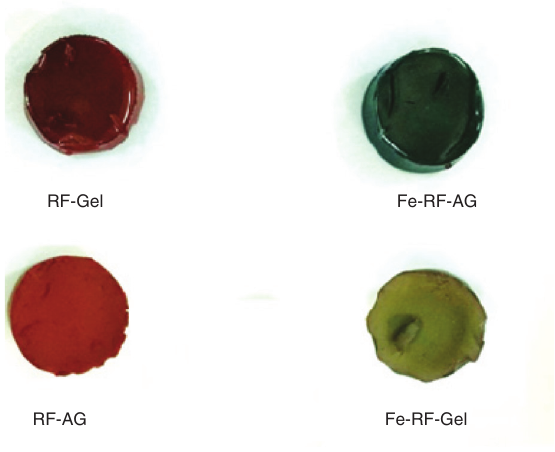
Figure 3 Photos of the synthesized samples: RF-Gel, Fe-RF-Gel, RF-AG and Fe-RF-AG.